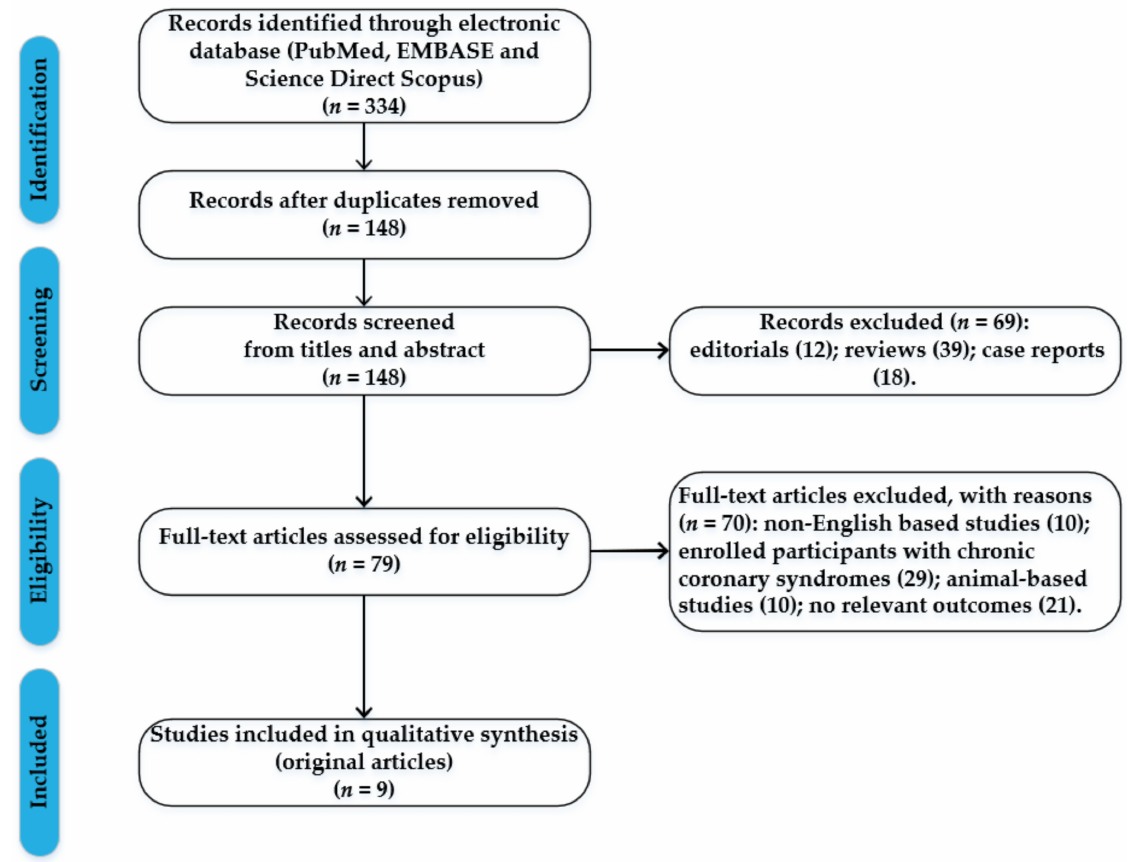
Figure 1. Flow chart with the process of article